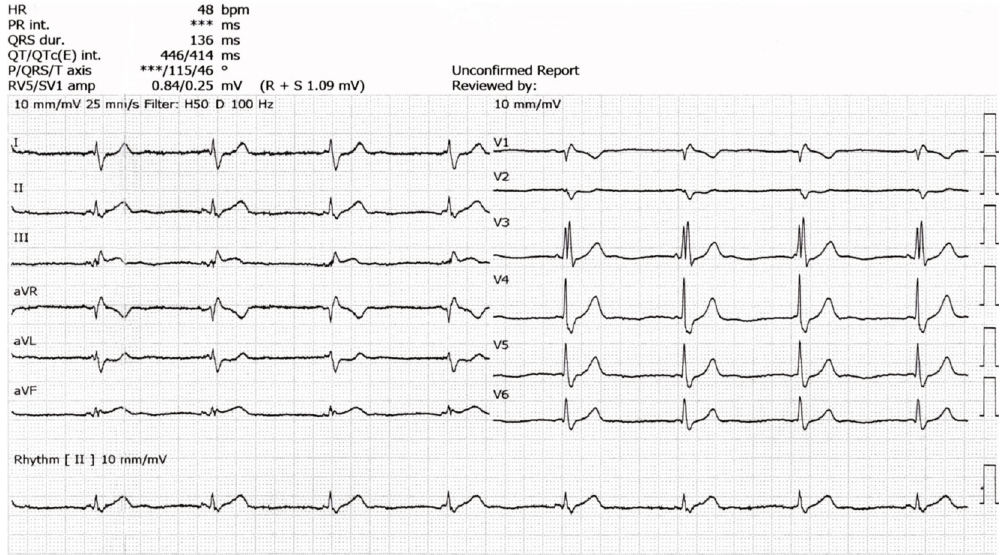
Figure 2: Electrocardiogram (ECG) shows right bundle branch block (RBBB).